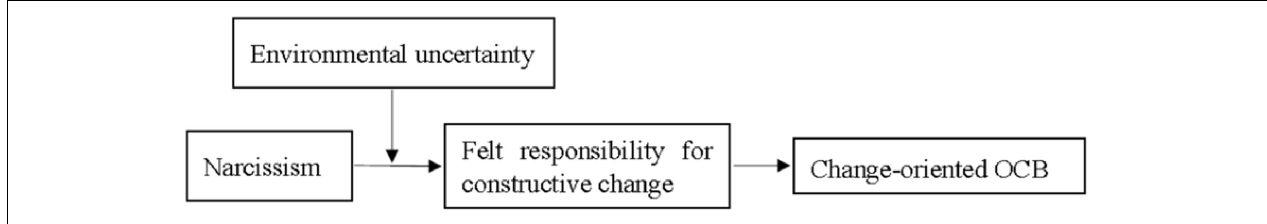
FIGURE 1 | Theoretical